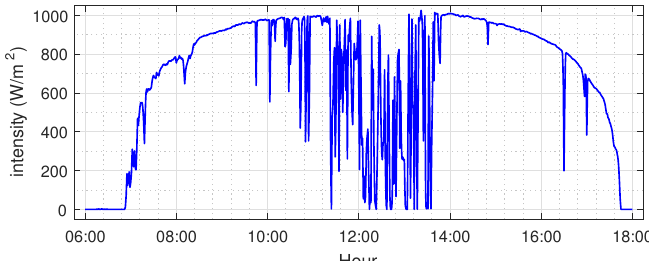
Figure 1. Solar intensity measured at Lowry Range Solar Station on 18 March 2013 [31].